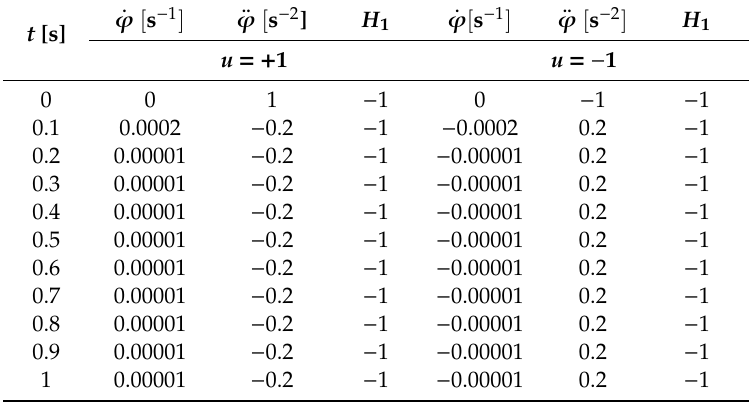
Table 3. Angular velocities, accelerations, and Н -functions of the machined shaft.